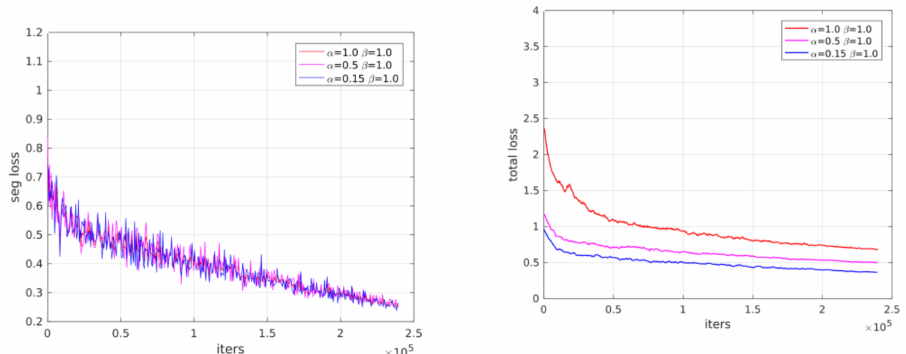
Figure A2. Training evolution of models with different weight settings of edge detection ( α ) and semantic segmentation ( β ). On the left is the semantic segmentation loss, and on the right is the total